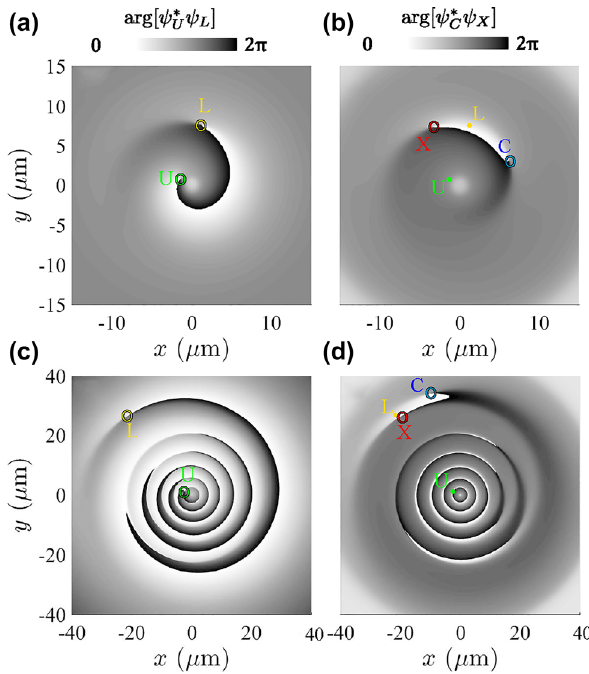
Figure 5: Relativephasesandvortexcorespositionsatdifferenttimes. (a) and (c) Show the phase map of σ = ψ * phase between the upper and lower fi elds, at t = 3.15 ps and t = 8.14 ps, respectively. The corresponding phase map of ψ * the exciton and photon fi elds, is shown in panels (b) and (d), at the same times as (a – c). The position of the vortex cores in all the fi elds are shown by C, X, L, U labels (for photon, exciton, lower polariton and upper polariton). The upper mode, excited by the second and tight pulse, undergoes a rapid diffusion, and the initial vortex core remains little affected by interferences, remaining almost at the center of the packet, close to the origin of the 2D map (green